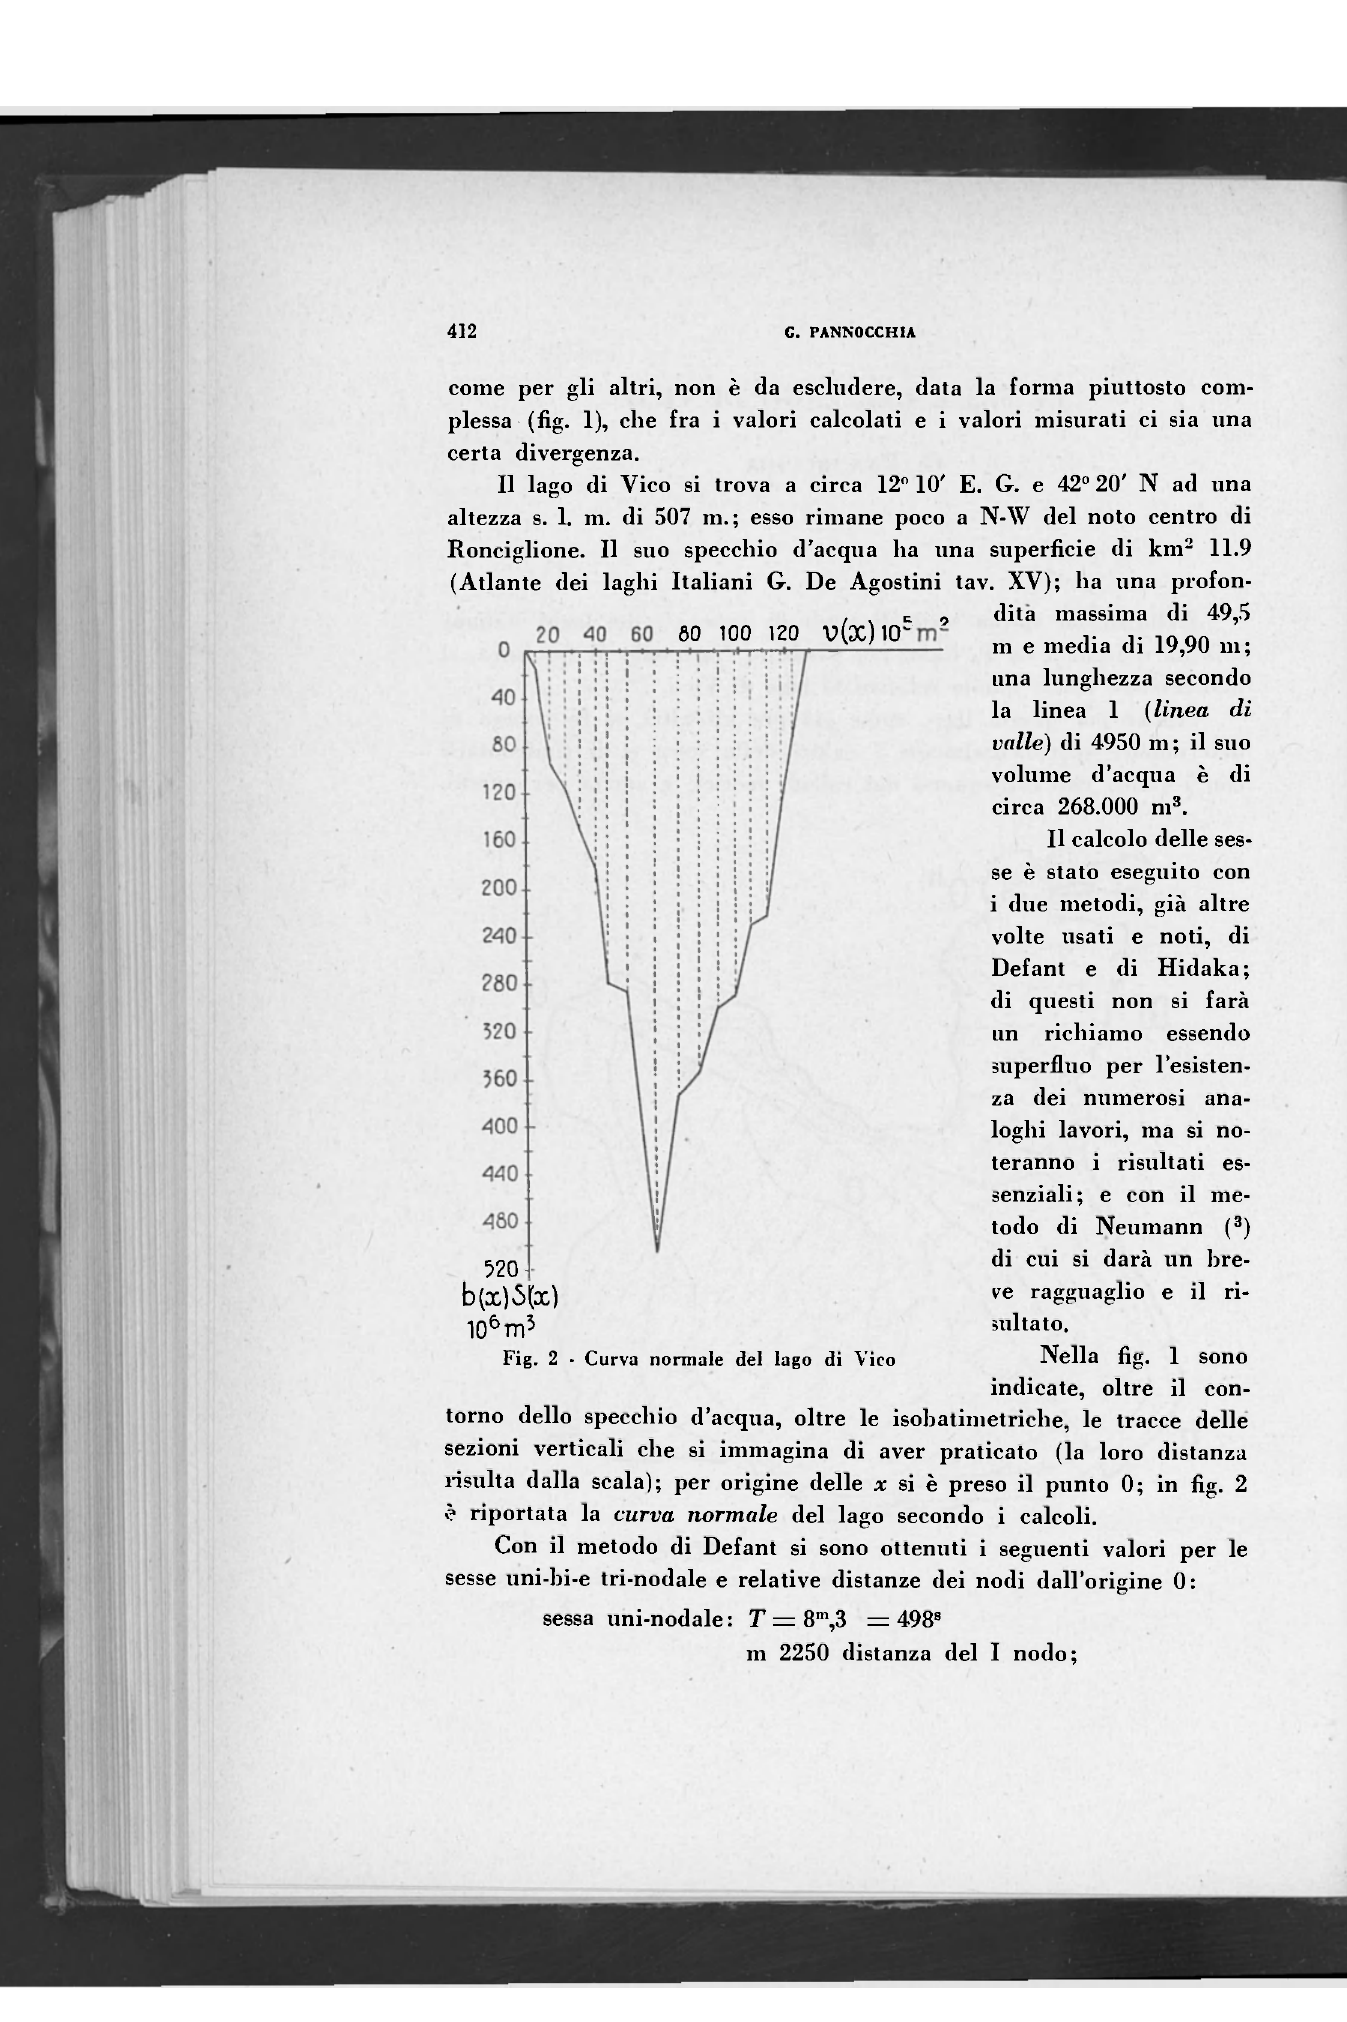
Fig. 2 - Curva normale del lago di